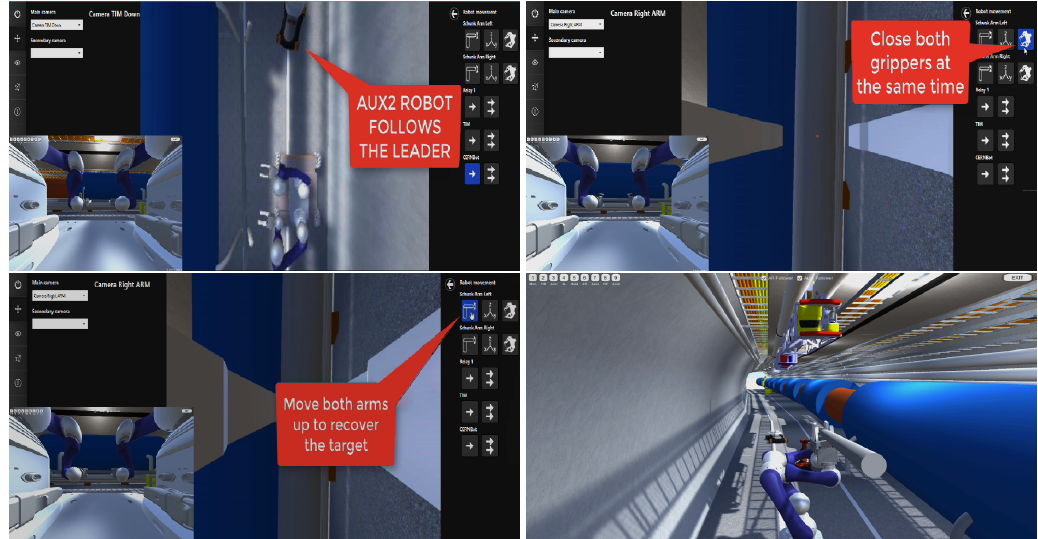
Figure 8. Dual-arm pipe recovery at a Large Hadron Collide (LHC) simulation server using the following behaviours and auxiliary robots for external